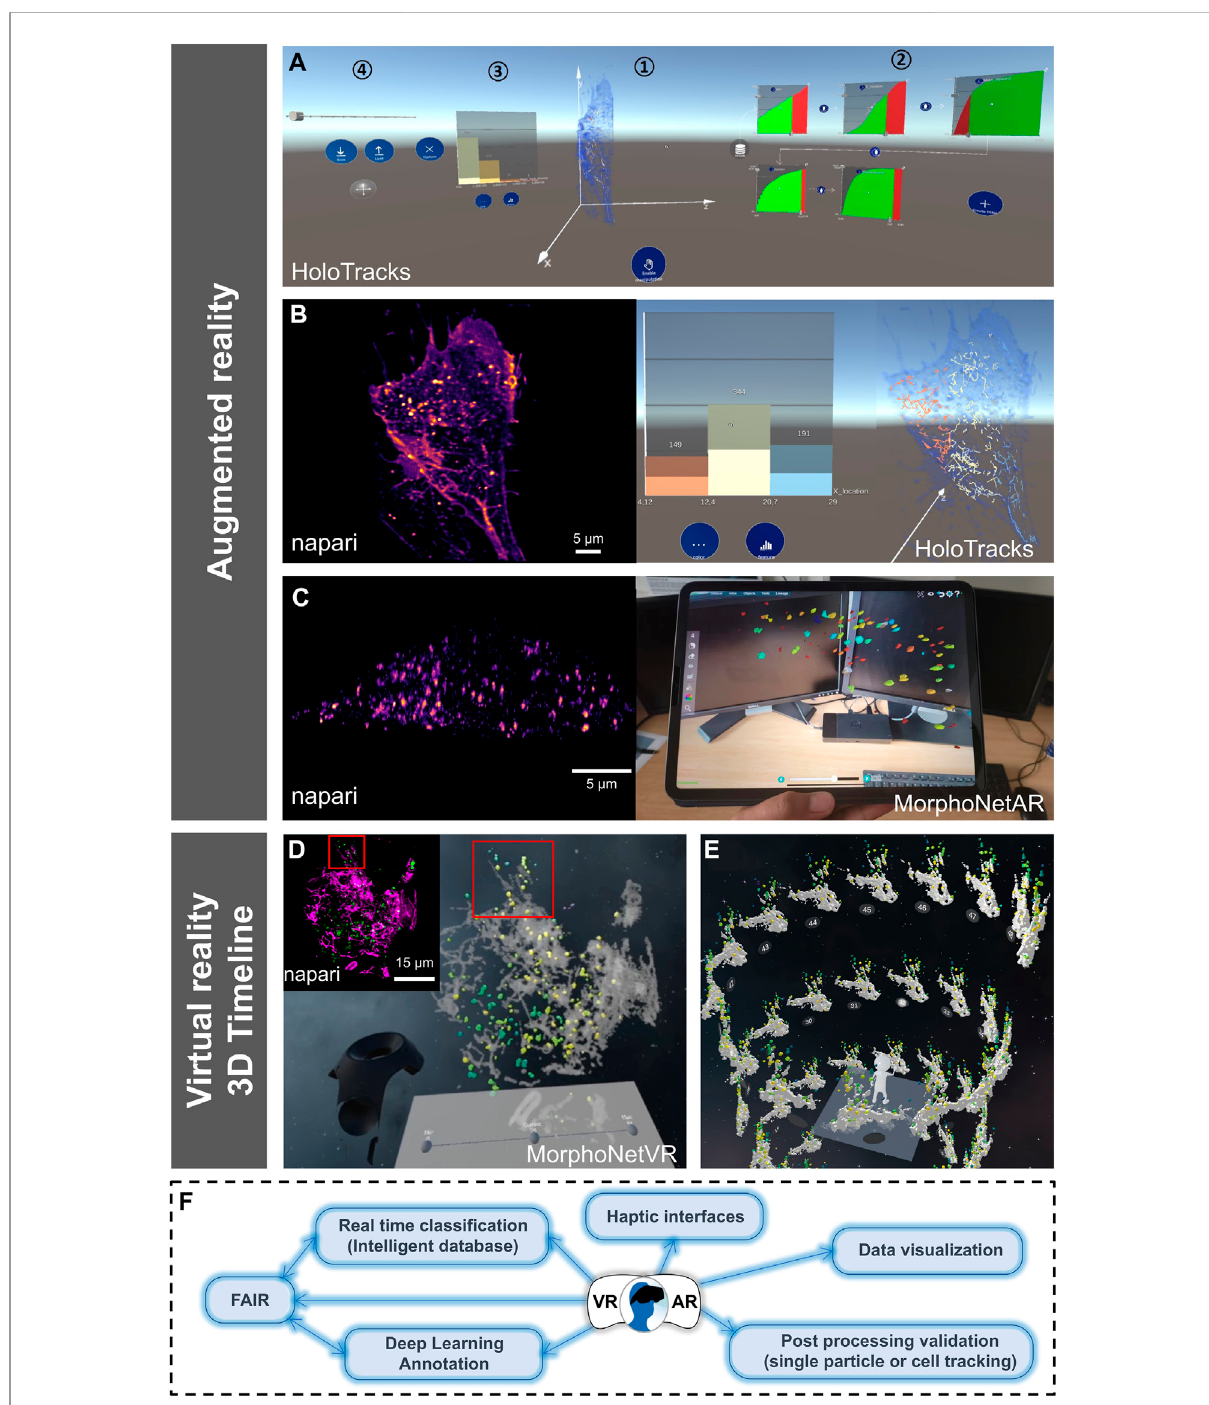
FIGURE 2 Other VR/AR developments and perspectives for VR/AR integration in the 3D + time digital microscopy landscape. (A – C) Augmented reality visualization (HoloTracks) of live RPE1 cell stacks acquired by Lattice Light Sheet microscopy after 1 h of incubation at 37 ° C with Plasma Membrane CellMask ™ staining (ThermoFisher, Bordeaux, France) to label the endosomal pathway. Tracking of labeled vesicles was performed with Trackmate (Ershovetal.,2022). (A) Augmented Realitydatadashboard thatcombinesa3Dview(1)withseveralabstractdataviews(2and3)andinteractive elements (1, 2, and 4) showing 3D view and possible data exploration ( fi lter settings and resulting histograms) or view manipulations as facilitated by theMicrosoftHoloLens2headset. (B) Pairedimagesshowingthesamecellsample,usingnapariviewer(leftimage)andHoloTracks(rightimage)with color map of tracks visualization of moving endosomes and histograms of three distributions as selected by fi ltered settings. (C) Napari (left image) andaugmented realityvisualization usingtablettechnology (MorphoNetAR;rightimage) ofonestack ofalive Helacellstablyexpressing